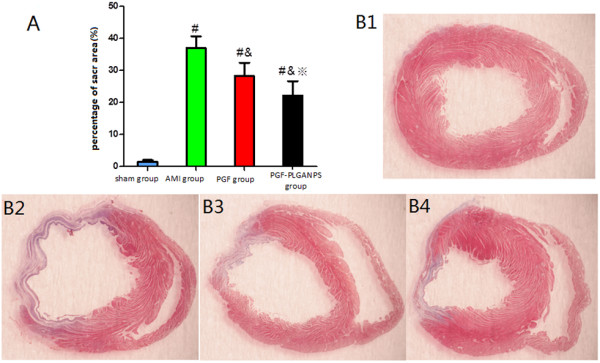
Effect of PGF on myocardial scar formation after AMI. A: A bar graph showing the average scar area in different groups. Symbols indicate significant differences (P < 0.05) from the control group (#), from the non-treatment AMI group (&), and from the nude PGF group (※), respectively. B: Digital images (×7.5) of tissue sections stained by Masson Trichrome in the control group (B1), AMI group (B2), PGF group (B3) and PGF-PLGANPs group (B4). Red color indicates viable myocardium, while blue color indicates fibrosis due to infarction damage.